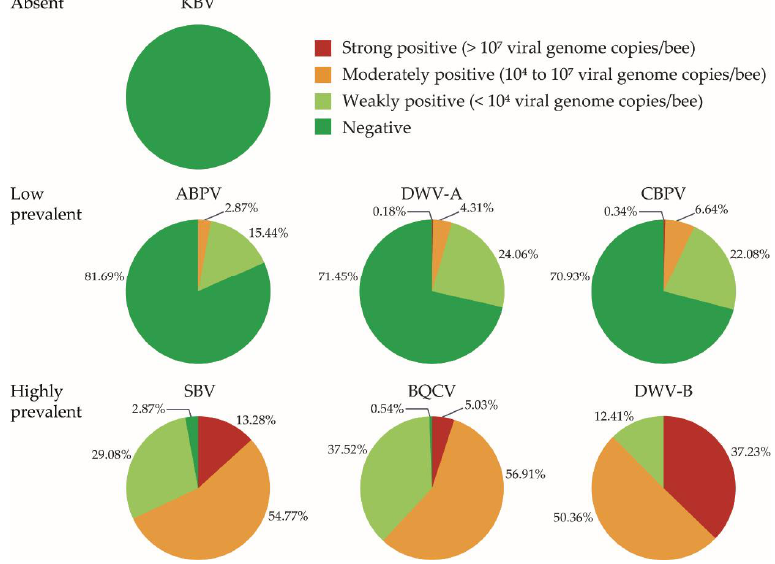
Figure 2. Prevalence and viral load of 7 viruses in 557 colonies of 155 apiaries homogeneously distributed over Belgium. When analyzing the data from apiaries from Flanders and Wallonia separately (Table 3), we found a significant difference between the prevalence of ABPV and DWV-A between both regions. In Flanders, 8.8% of the colonies were infected with ABPV, while 26.5% of the colonies from Wallonia were positive for ABPV (Fisher exact test; p < 0.001). DWV-A was detected in 18% of the Flemish colonies and in 37.75% of the colonies in Wallonia (Fisher exact test; p < 0.001). The differences between the regions for the other viruses were not significant (Fisher exact test; p > 0.05). Table 3. Percentages of positive colonies per virus in honey bee colonies from Flanders and Wallonia and indications of increase (+) or decrease (-) compared to previous studies. Virus